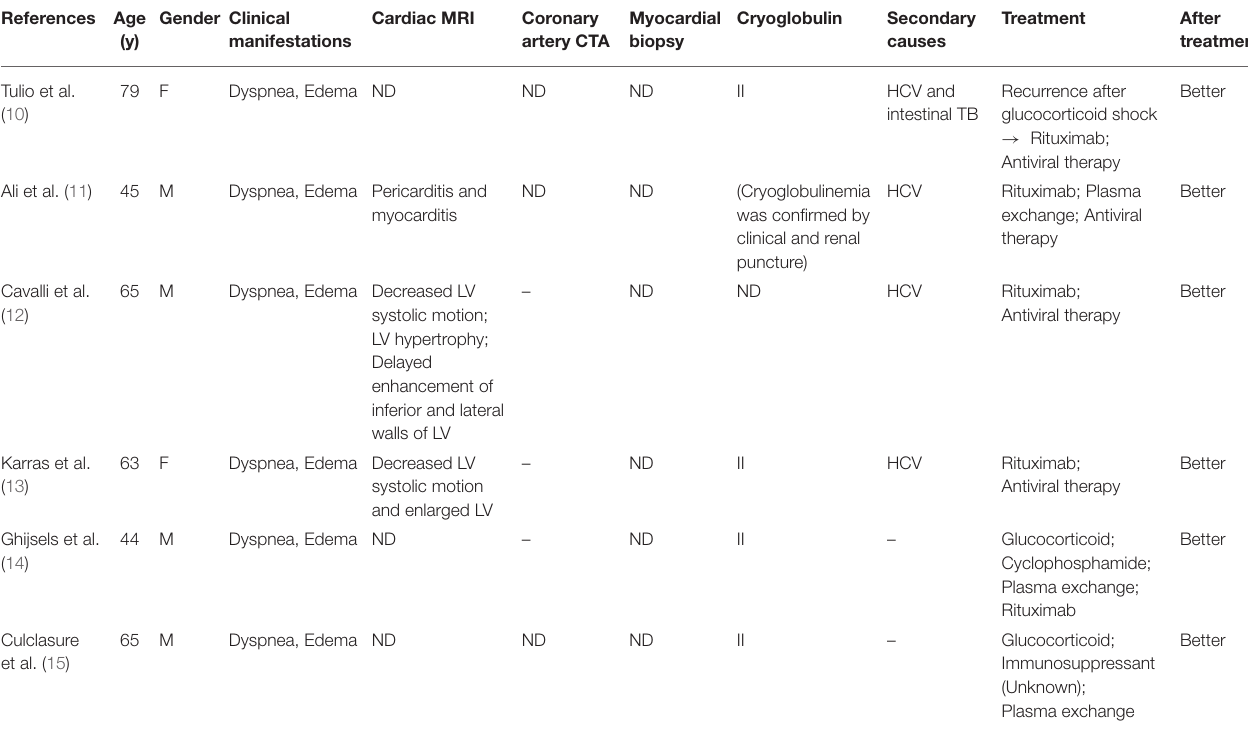
TABLE 3 | Cardiac involvement related to cryoglobulinemia reported in the